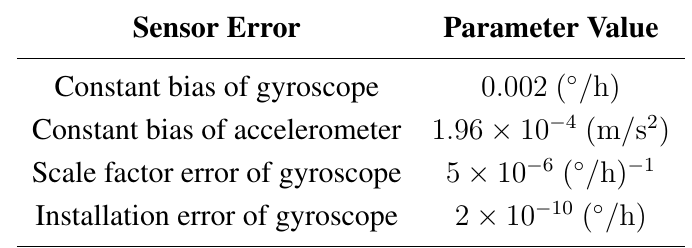
Table 3. Inertial sensor performance (Group